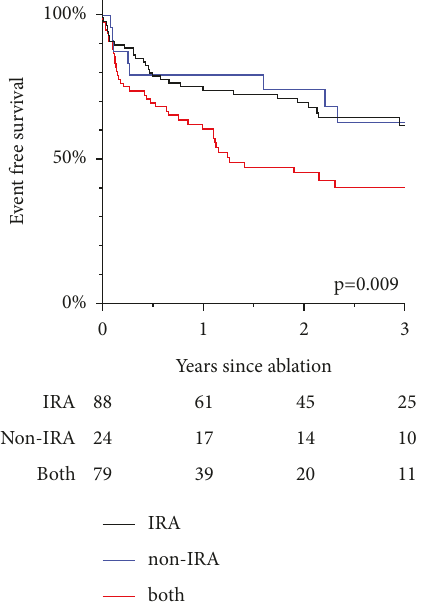
Figure 5: VT recurrence comparing infarct-related artery (IRA), non-IRA and presence of